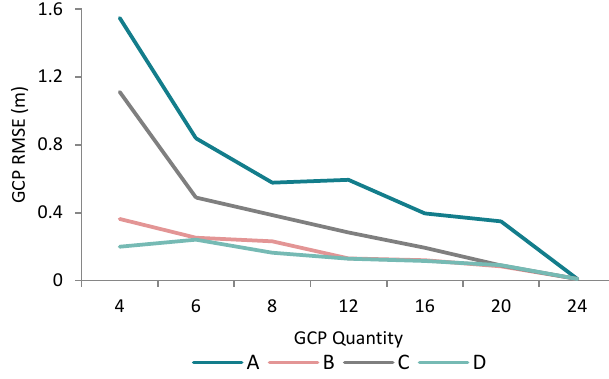
classes with respect to the GCP quantity